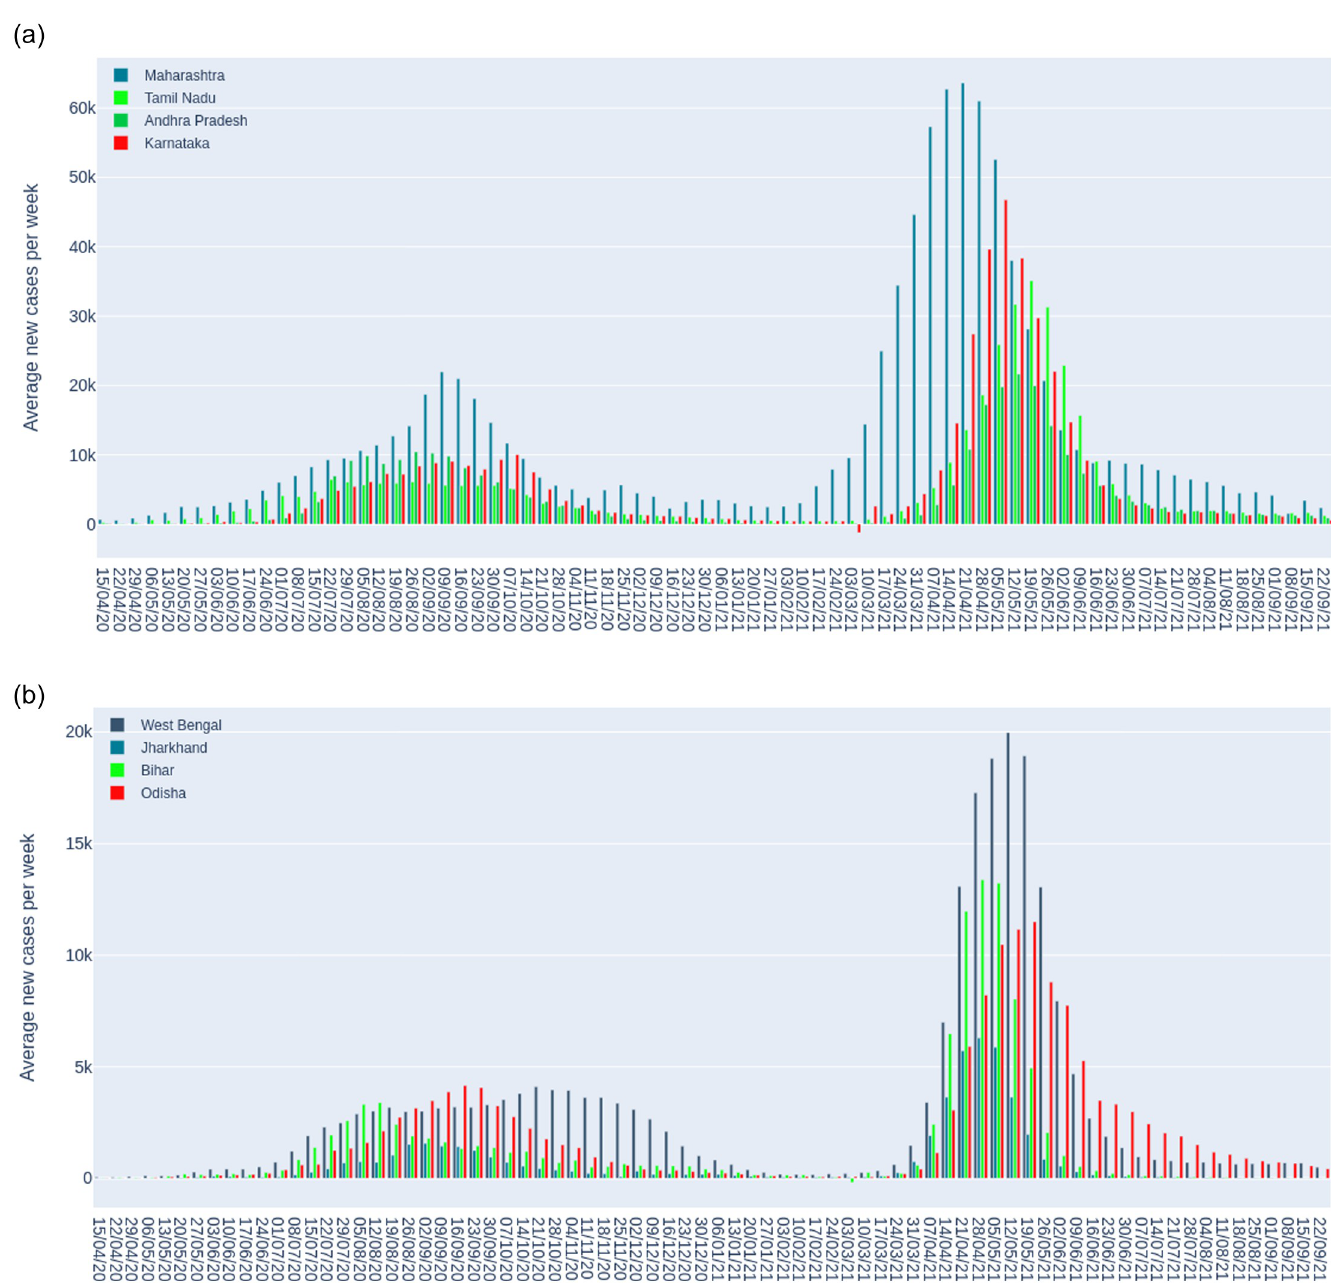
Fig 4. Weekly average of new cases for groups of Indian states and union territories